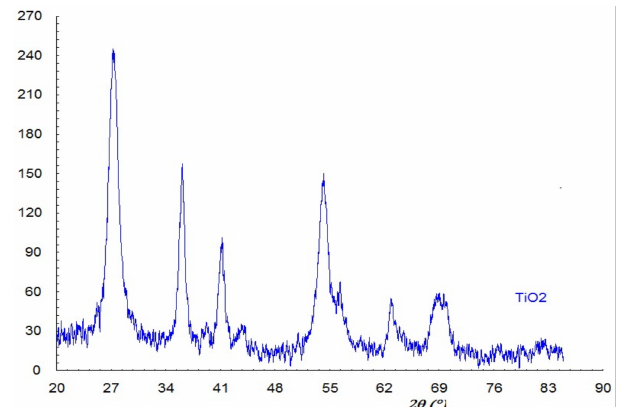
Figure 1. Diffractogram of TiO 2